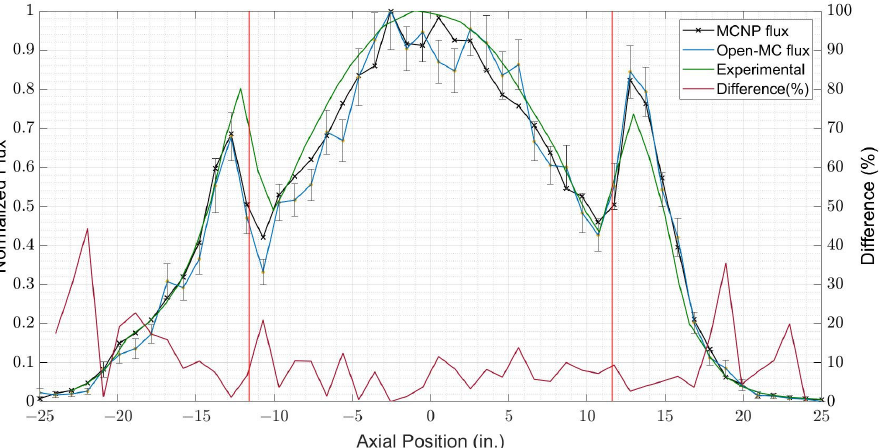
Figure 10. MSTR fl ux pro fi le produced by the MCNP5 and OpenMC models. MCNP5 fl ux data were Figure 10. MSTR flux profile produced by the MCNP5 and OpenMC models. MCNP5 flux data were obtained from reference [12], where the di ff erence (%) line indicates the error percentage between obtained from reference [12], where the difference (%) line indicates the error percentage between MCNP5 and OpenMC, while the vertical red line indicates the active fuel region. MCNP5 and OpenMC, while the vertical red line indicates the active fuel